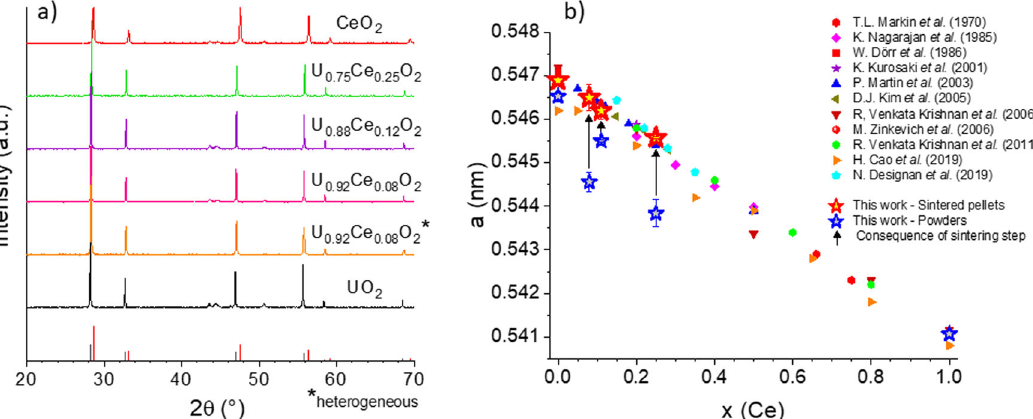
Fig. 1 XRD patterns and lattice parameters. a XRD patterns of ground pellets sintered at 1600 °C under Ar/H 2 atmosphere compared to the references UO 2 [PDF-00-041-1422] (black vertical lines) and CeO 2 [PDF-03-065-5923] (red vertical lines). b Lattice parameter values obtained from XRD patterns re fi nement of raw powders and ground sintered pellets compared to data reported in the literature. Error bars are twice the standard